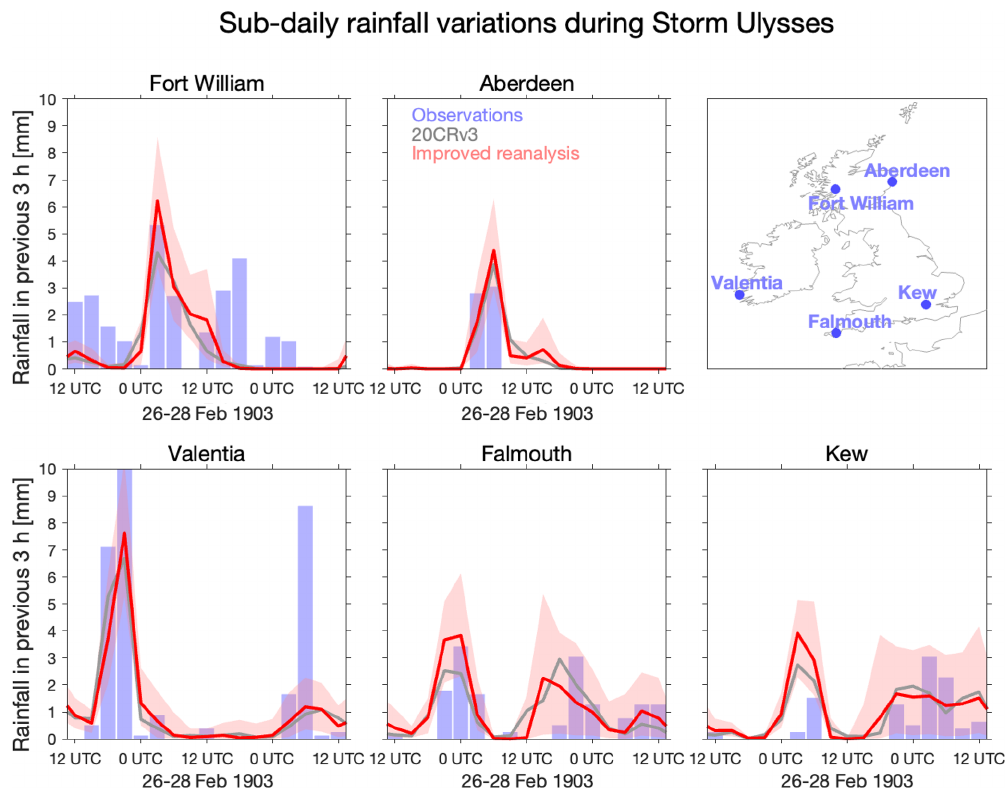
Figure 8. Assessing high-frequency rainfall variations. Rainfall every 3h during Storm Ulysses from 20CRv3 (ensemble median in grey) and the reanalysis with new observations and improved assimilation (ensemble median and 16%–84% range in red) between 12:00UTC on 26 and 12:00UTC on 28 February 1903 for five locations across the British and Irish Isles. The 16%–84% range is roughly equivalent to showing the ensemble standard deviation but is more appropriate for a non-normally distributed variable, such as high-frequency rainfall amounts. These locations have hourly rainfall observations available which have been integrated over the same 3h periods (blue bars) as produced by the reanalysis. None of the rainfall data are assimilated in the reanalyses, and so the observational data and reanalysis output are